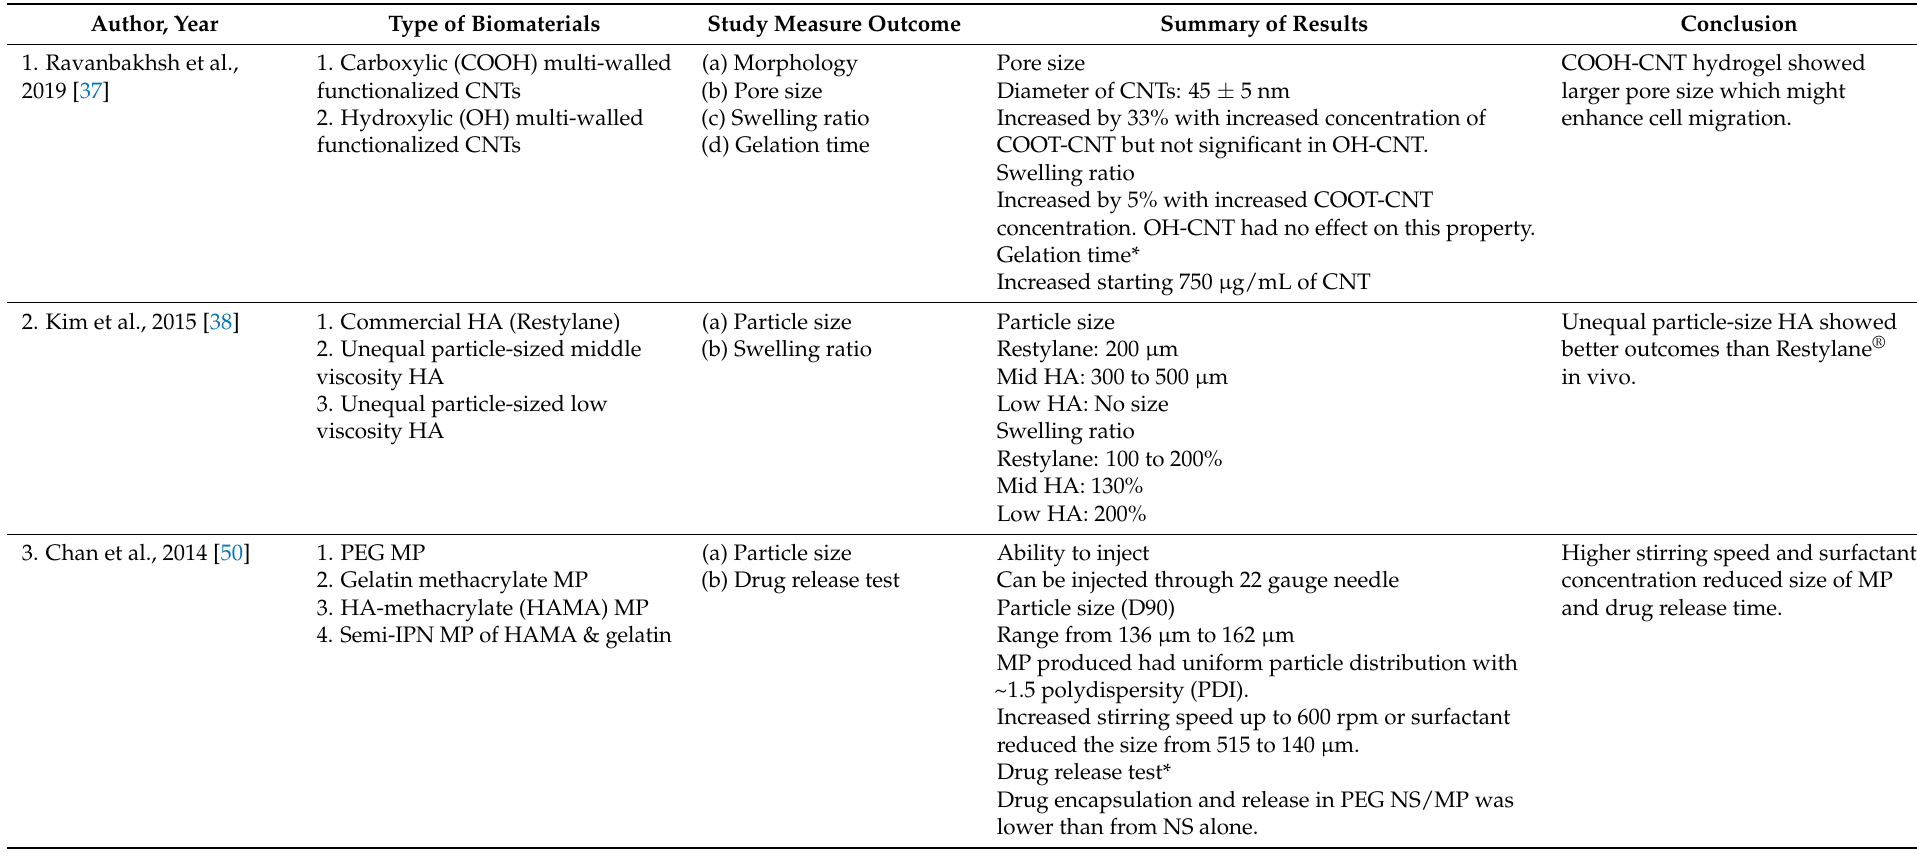
Table 3. Other characterization